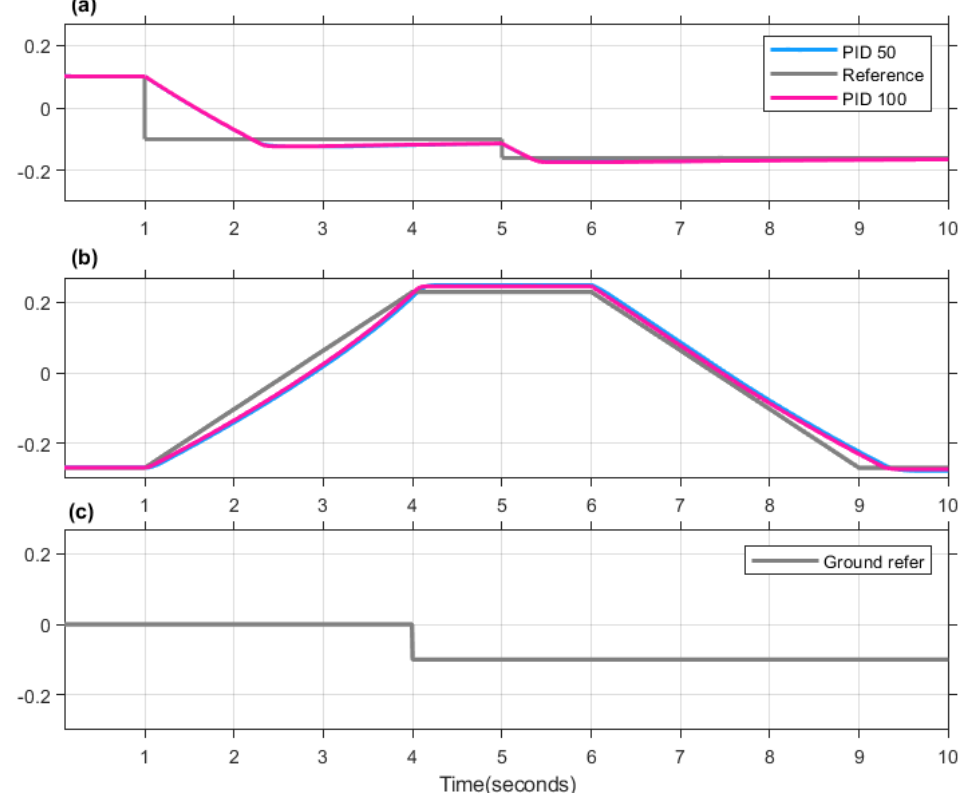
Figure 6. Reference and actual motion of the multibody model of the operating machine for: ( a ) sink- ing of the operating machine; ( b ) handling for effort control; ( c ) Abrupt change in the terrain